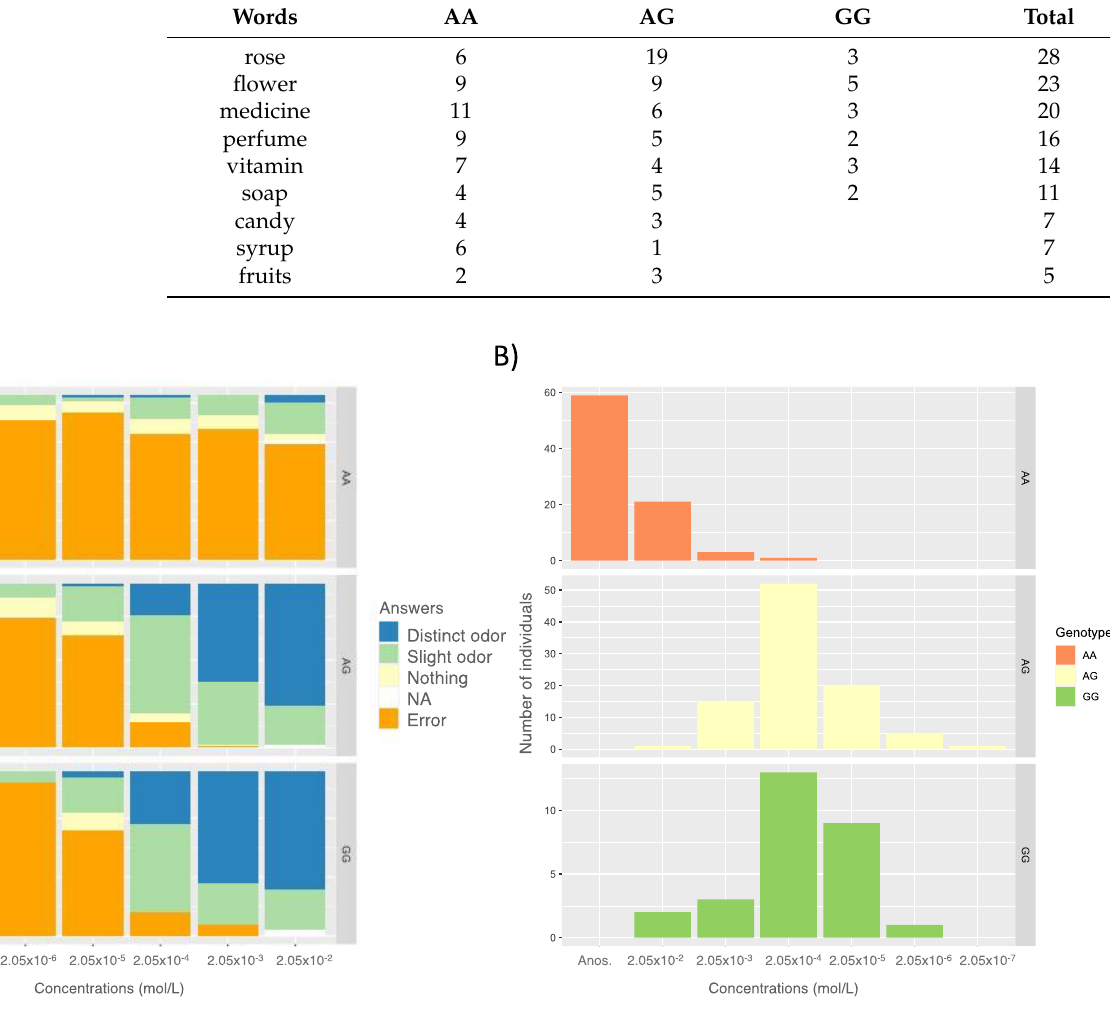
Table 1. Qualitative description of beta-ionone: number of participants (per genotype and total) using each descriptor (only descriptors used by more than five participants are shown).